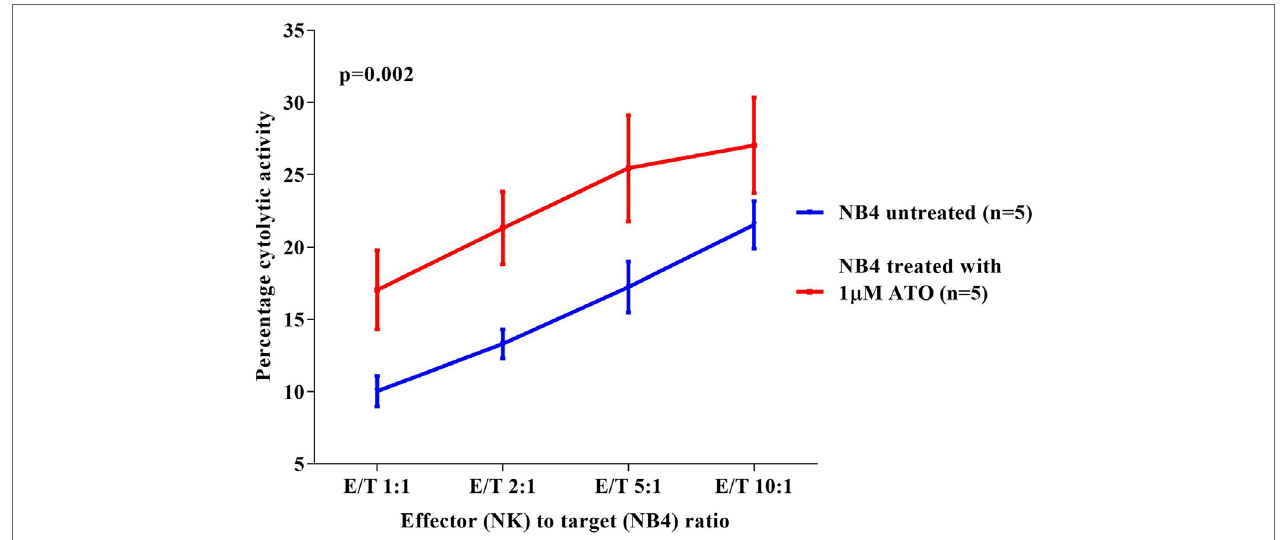
FigUre 2 | Comparison of percentage cytolytic activity of NK92MI cell line toward NB4 untreated and treated with arsenic trioxide (ATO) (1 µM for 12 h). The CFSE labeled NB4 cells (1 × 10 5 cells untreated or treated with 1 µM ATO for 12 h) were co-cultured with effector cells (NK cell line) in different E:T ratios 1:1, 2:1, 5:1, 10:1 in a 24-well plate with 500 µl 10% RPMI media. At the end of incubation at 37°C for 5 h, the cells were washed, and 2.5 µl of 7AAD was added to the samples and acquired in FACS Calibur. The percentage cytolytic activity was calculated, and the values were plotted as mean with SEM ( n = 5). p -value less than 0.05 was considered significant.